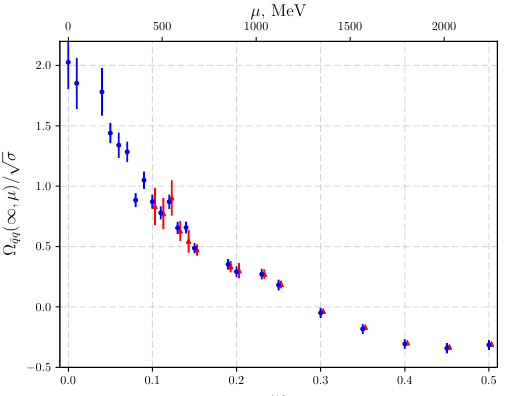
Figure 5 . The renormalized color singlet grand potential (cid:10) 1 ( 1 ; (cid:22) ) as a function of (cid:22) . The red tringles correspond to the (cid:10) 1 ( ; (cid:22) ) extracted from the renormalized correlators of Polyakov loops. 1 The blue circles correspond to the (cid:10) 1 ( ; (cid:22) ) extracted from the average Polyakov loops measured 1 on the lattice and renormalized according to formula (4.8).